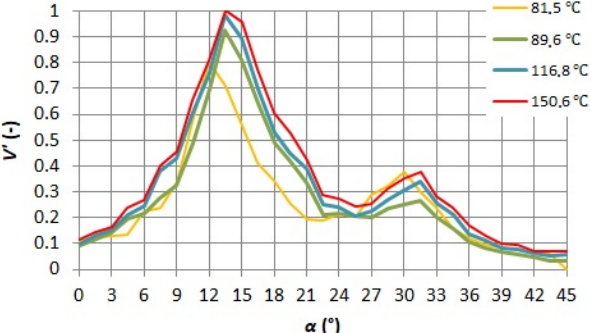
Figure 8. Relationship between EOG normalized values and the angle α for different temperature values ϑ p of the observed element.